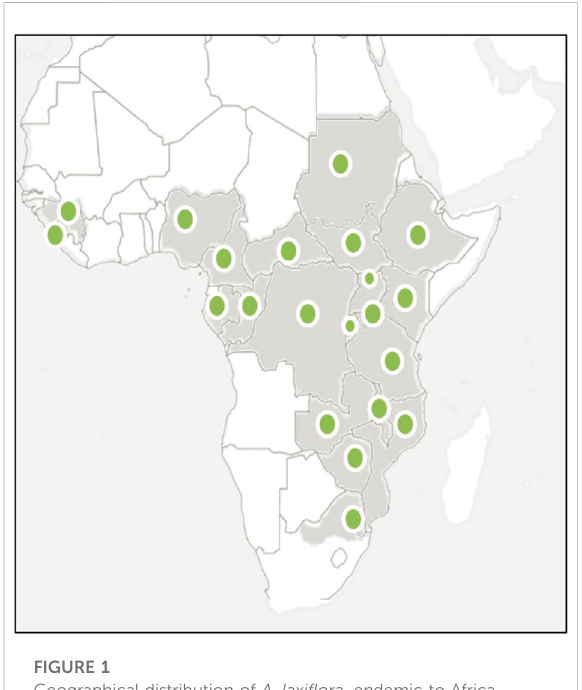
FIGURE 1 Geographical distribution of A. laxi fl ora , endemic to